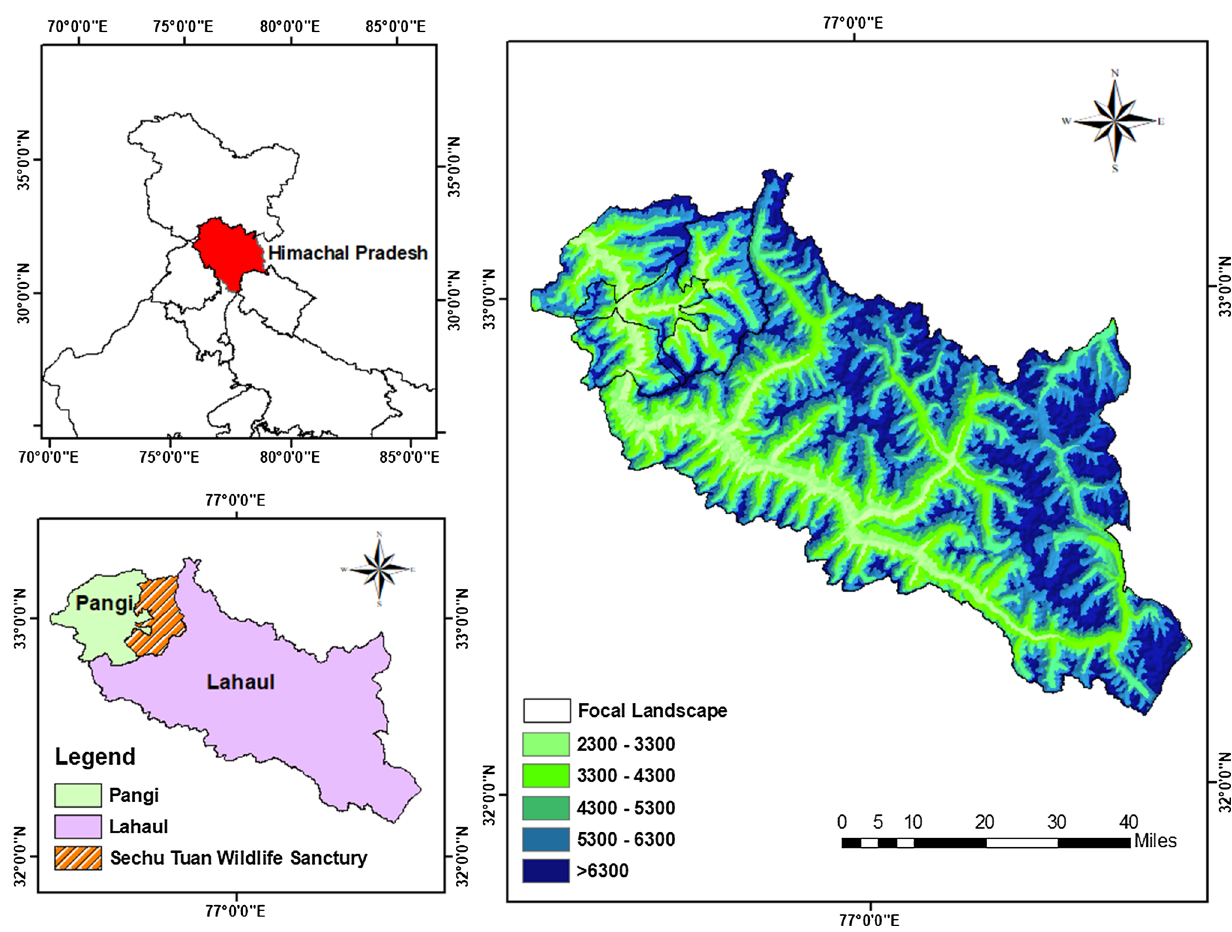
Fig. 1 Map showing Lahaul and Pangi landscapes in Himachal Pradesh,